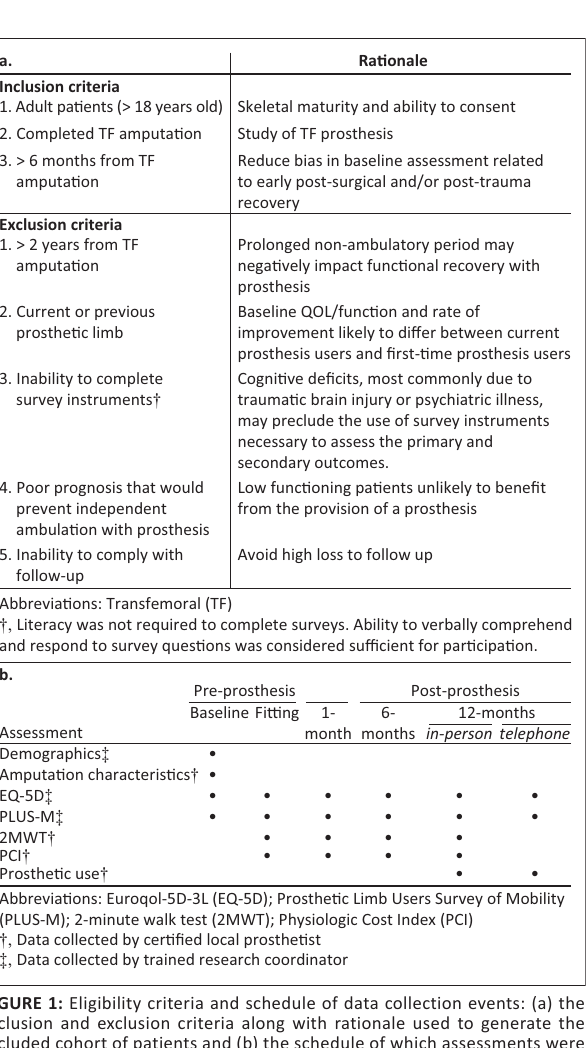
FIGURE 1 : Eligibility criteria and schedule of data collection events: (a) the inclusion and exclusion criteria along with rationale used to generate the included cohort of patients and (b) the schedule of which assessments were performed at each timepoint throughout the study. The data collected at 12 months was dependent on whether the visit was conducted in-person or by